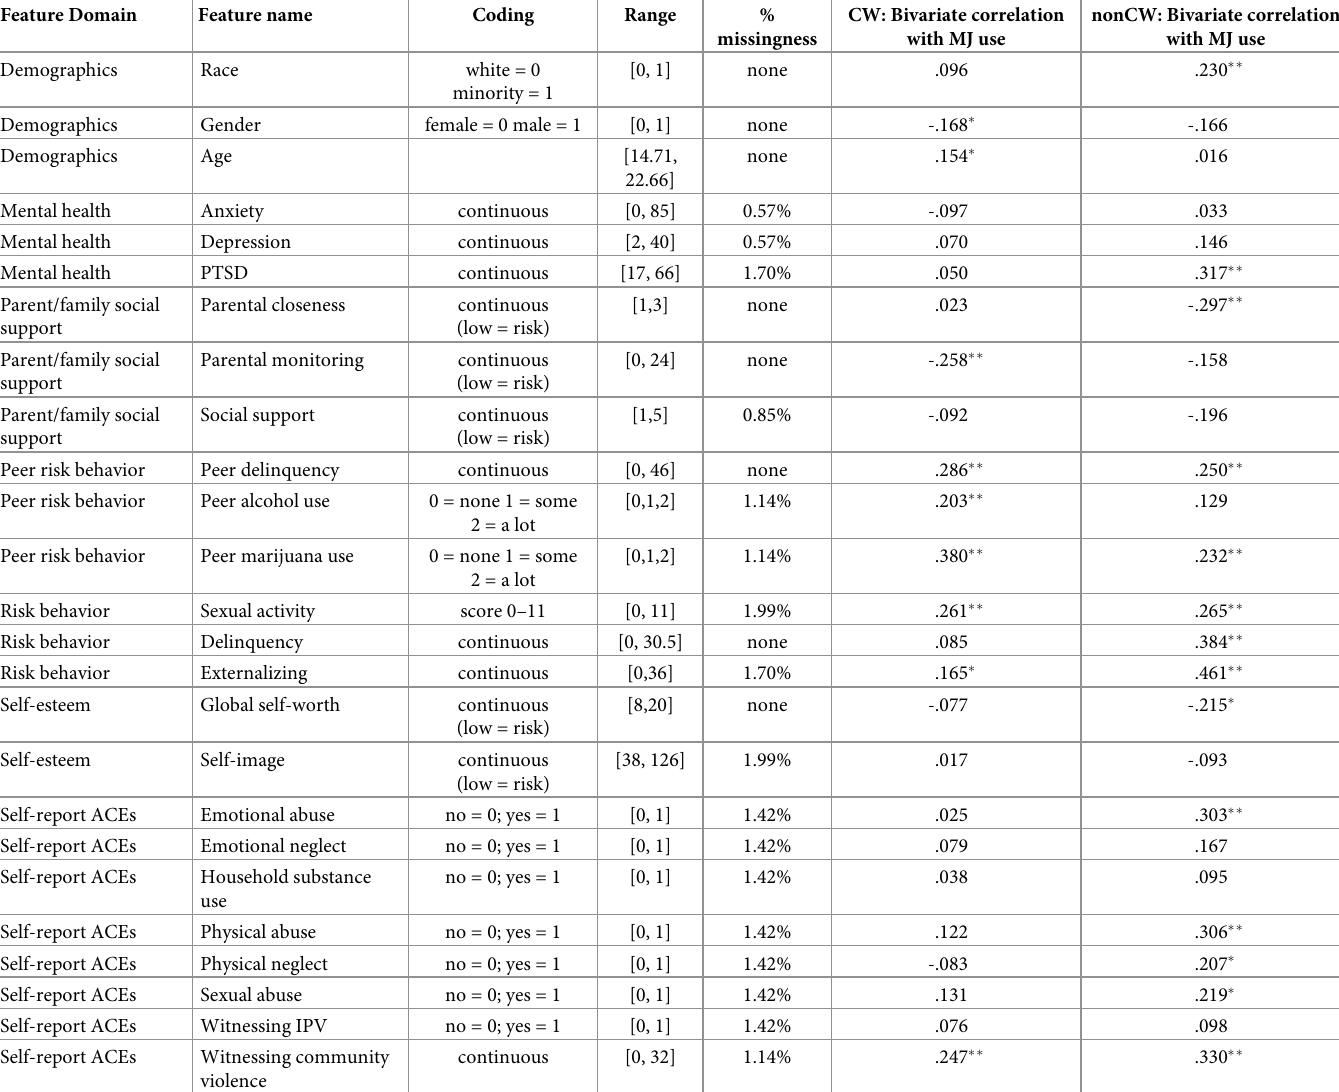
Table 2. Individual predictor variables (features), domains, and